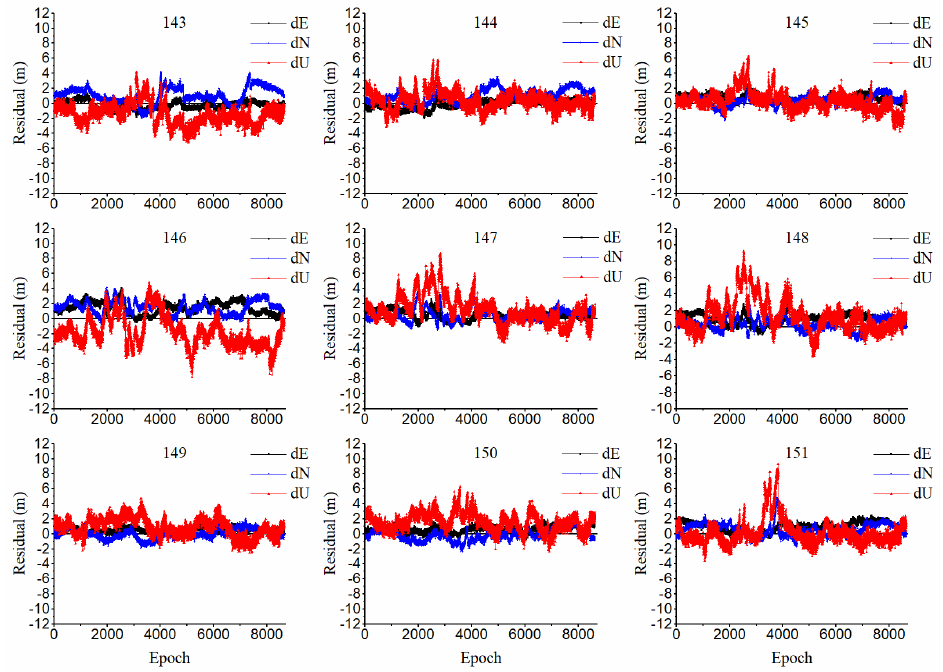
Figure 10. Positioning residuals of single-point positioning (SPP) with GPS code measurements.